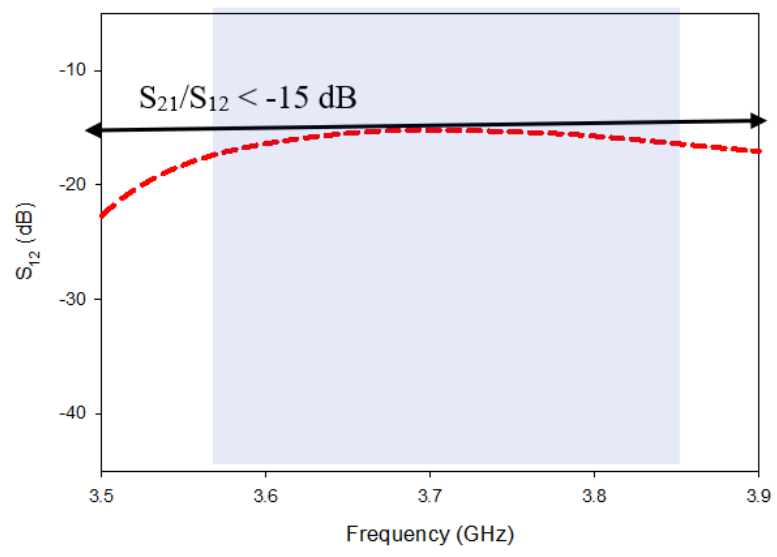
Figure 5. Mutual coupling of Design-1.